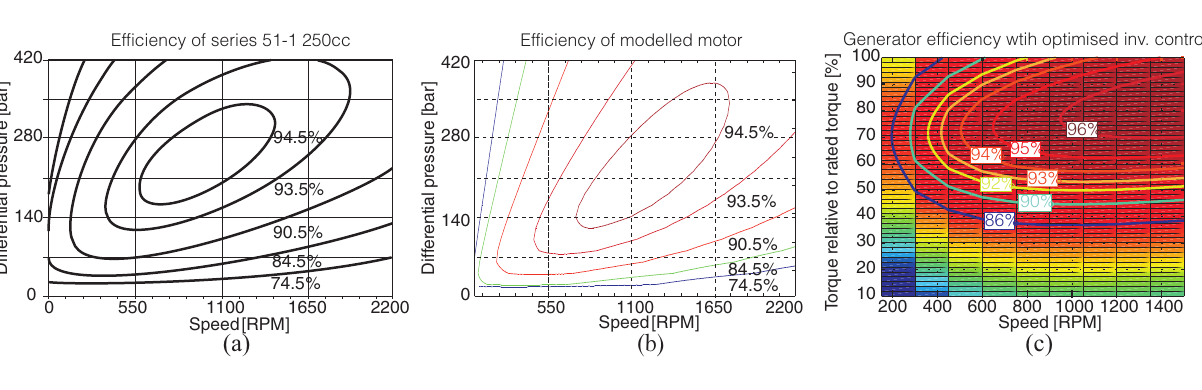
Figure 17. ( a ) efficiency plots (from datasheet) of a Sauer-Danfoss 250 cc Series 51-1 bent-axis motor at full displacement; ( b ) the efficiency of the modelled motor; and ( c ) the efficiency of a generator when inverter control is configured for optimal